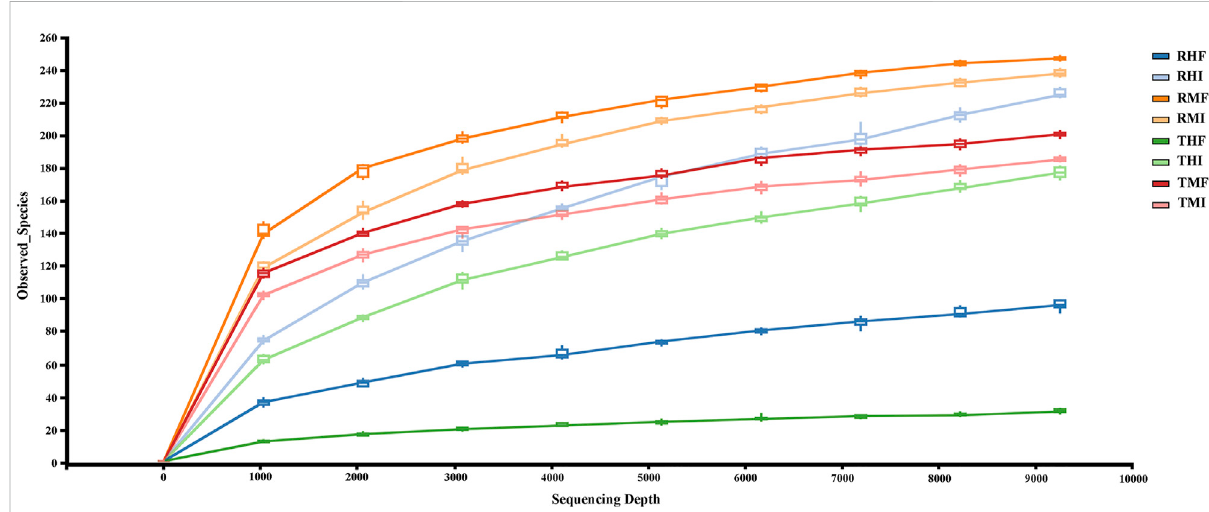
FIGURE 1 Rarefactioncurves(Sobs)andestimatorswithdifferentsamples.Eachrarefactioncurverepresentsasequencinggroup.Thecolorofeachcurve corresponds to each intestinal sample group. RMI = IPRS, midgut, D7; RMF = IPRS, midgut, D90; RHI = IPRS, hindgut, D7; RHF = IPRS, hindgut, D90; TMI = PCS, midgut, D7; TMF = PCS, midgut, D90; THI = PCS, hindgut, D7; THF = PCS, hindgut, D90.